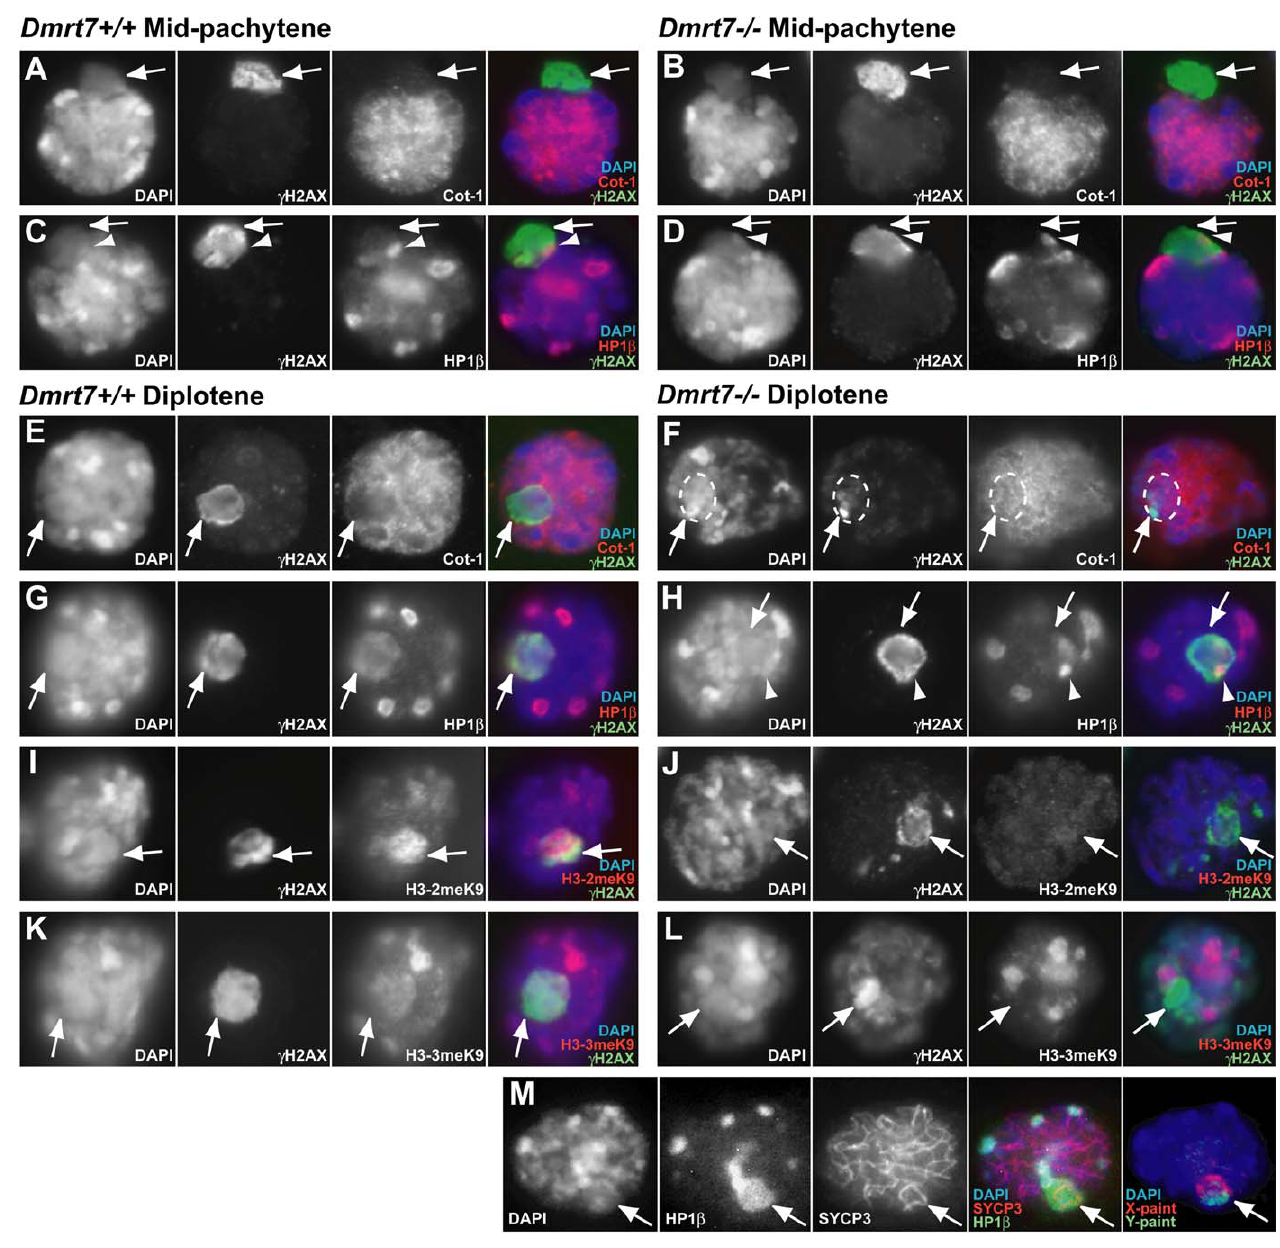
Figure 8. Chromatin Abnormalities in Dmrt7 Mutant Diplotene Germ Cells (A and B) MSCI occurs normally in mid-pachytene spermatocyte of Dmrt7 mutant. Arrows indicate XY body in all panels. Cot-1 RNA FISH (red) reveals normal silencing of sex chromosome transcription in XY body. This is consistent with wild-type mid-pachynema as described previously [16]. (C and D) HP1 b localization in mid-pachytene spermatocytes. HP1 b localizes to X chromosome centromere (arrowhead) in wild-type (C) and mutant (D). (E and F) Cot-1 hybridization in diplotene. Presumptive XY body, based on DAPI and c H2AX localization, is indicated by arrow in (F). (G and H) HP1 b in diplotene. Wild-type cell (E) has HP1 b throughout XY body, whereas mutant cell (H) only has localization to X chromosome centromere (arrowhead). (I and J) H3-2meK9 localization in diplotene cells. Mutant cell (J) lacks strong concentration of this mark to the XY body seen in wild-type (I). (K and L) H3-3meK9 localization in diplotene cells. Mutant cell (L) has no localization of this mark to the XY body. c H2AX localizes to autosomes in mutant cell, possibly indicating onset of apoptosis. (M) Example of mutant diplotene cell with normal HP1 b accumulation to the XY body. All images except those in (M) are single Z sections.